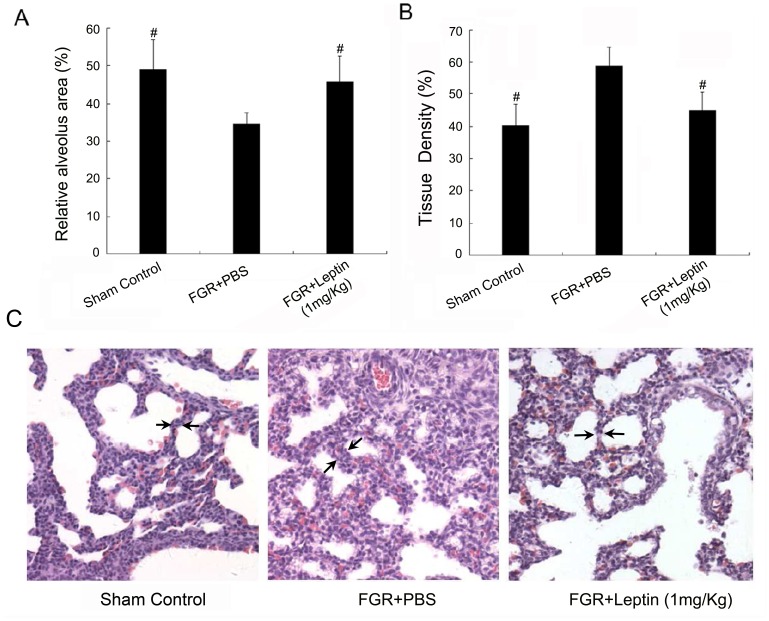
Leptin enhances the maturity of fetal lungs in the FGR rat model.A: The relative alveolus area is presented by the ratio of the alveolar area to the lung area, which was calculated by an image analysis program. #P<0.05 vs PBS-treated FGR group (n = 3). B: The field occupied by alveoli and lung tissue is presented as the tissue density, which was analyzed and calculated by ImagePro Plus image analysis software. #P<0.05 vs PBS-treated FGR group (n = 3). C: Histological examination of HE-stained lung tissue sections of fetal rats on day 21 of gestation showed a difference in pulmonary alveoli and interval (arrow noted) between the FGR group, leptin-treated group and control (×200).